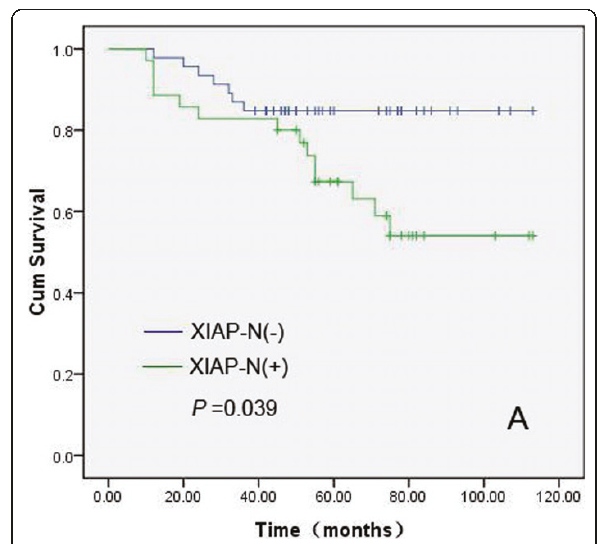
Figure 6 Kaplan-Meier comparison result showed that XIAP-N was correlated significantly with IDC patients ’ shortened overall survival . Log rank test P -value (two sided) was listed in the figure.